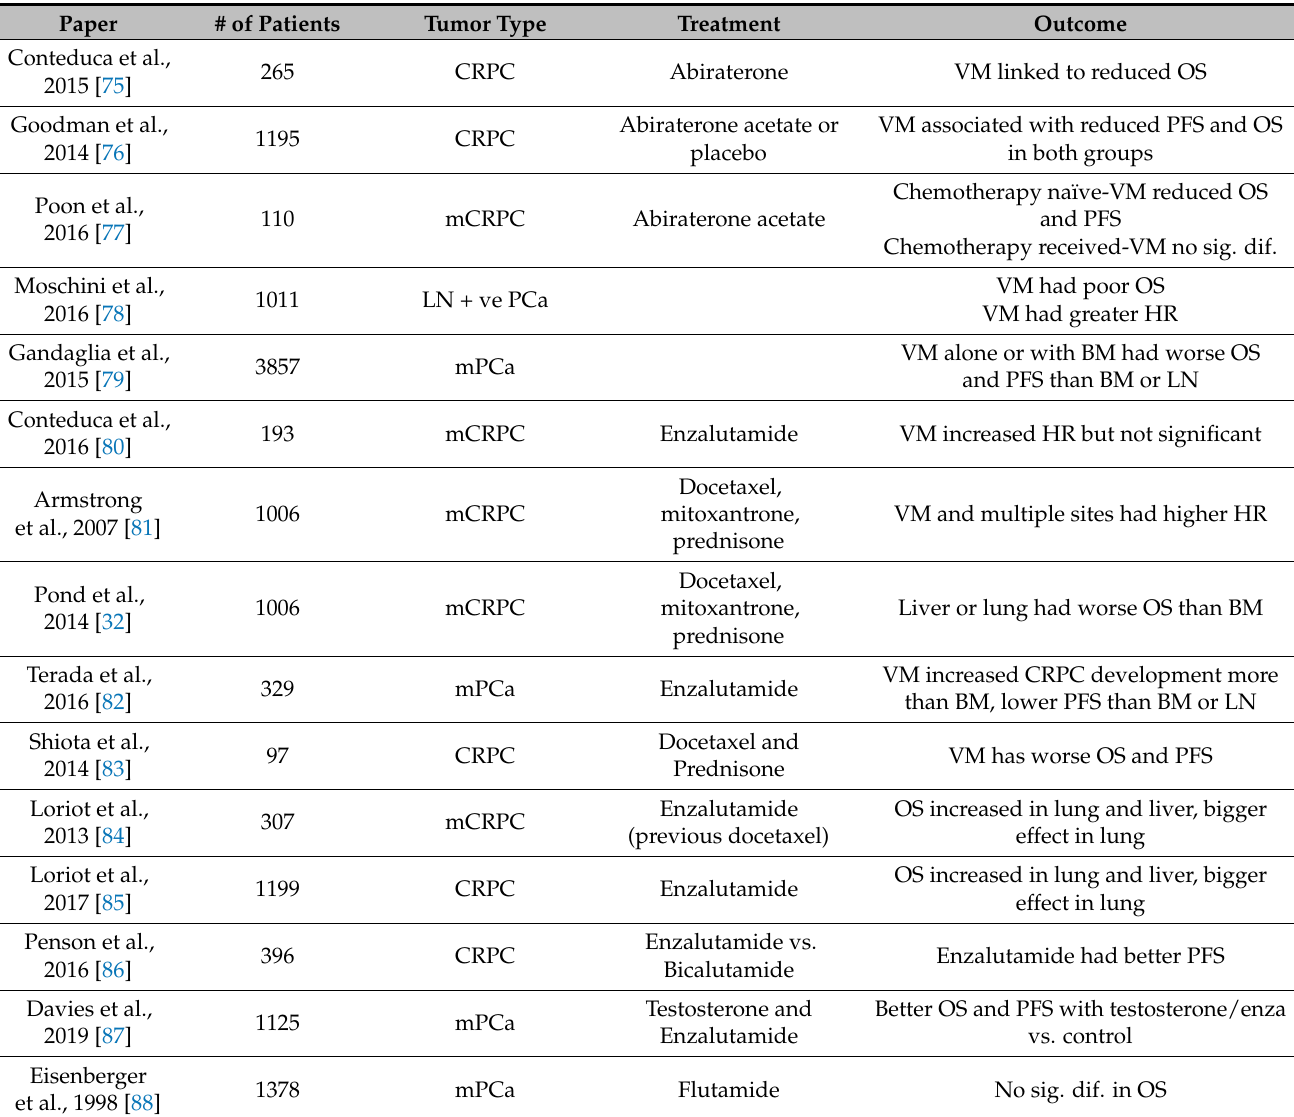
Table 1. Summary of clinical trials to assess efficacy of anti-androgen therapies and response of patients with visceral